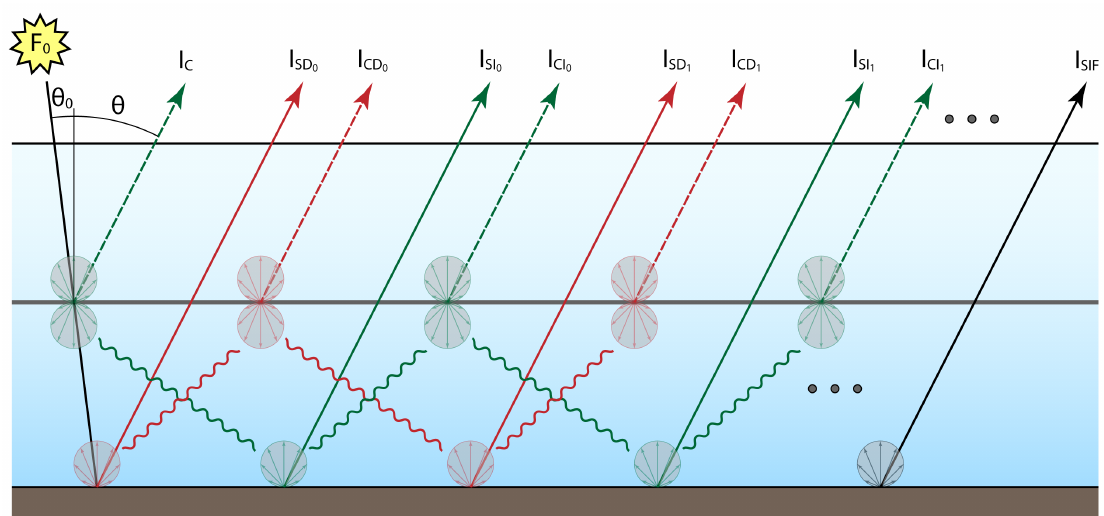
Figure 1. Basic radiative transfer setup with an absorbing atmosphere, a surface with Lambertian reflectance, and an optically thin semi-transparent layer which can partly transmit, absorb, or scatter light in an isotropic way. F 0 is the solar incoming flux, θ 0 and θ are the solar and satellite zenith angles, and I is the radiance reaching the satellite instrument split into components as discussed in the main text. Red represents radiation originating from direct illumination of the surface. Green represents radiation originating from direct illumination of the scattering layer. Arrows represent radiance components reaching the satellite instrument originating from the surface (solid) or from the scattering layer (dashed). Waved lines represent diffuse radiant